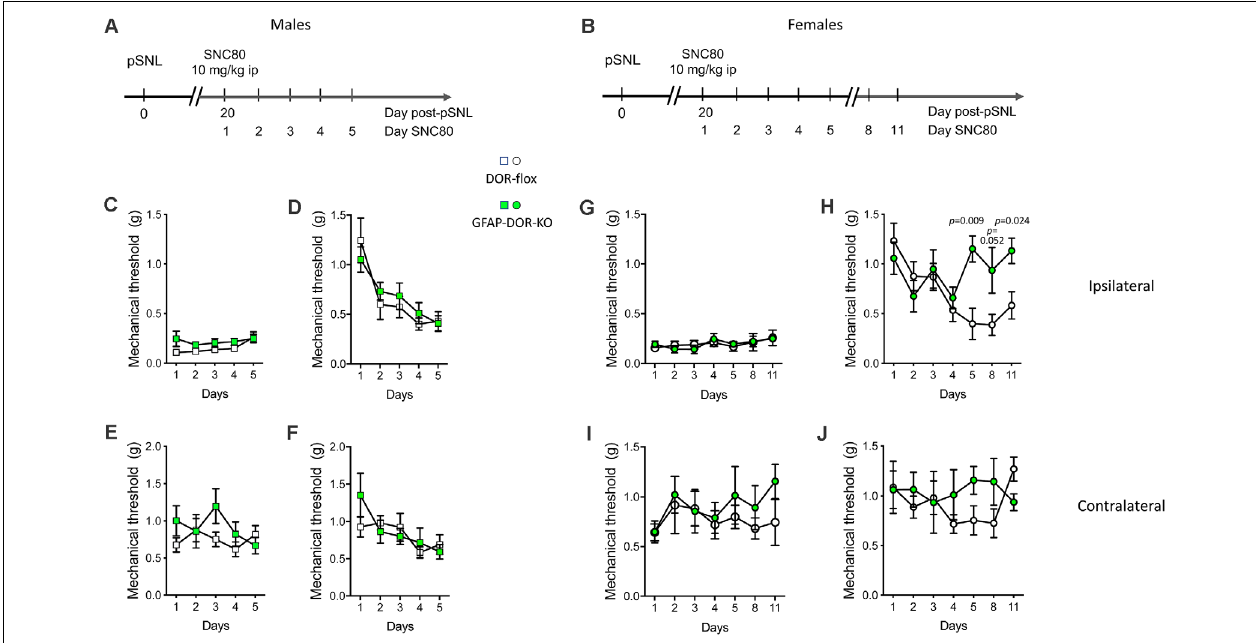
FIGURE 3 | Analgesic tolerance to SNC80 is abolished in GFAP-DOR-KO female mice. (A,B) Experimental design in males and females. SNC80-induced analgesia and analgesic tolerance was scored in neuropathic GFAP-DOR-KO and DOR-flox males (A) and females (B) . (C) Mechanical sensitivity in males each day before SCN80 administration, ipsilateral side. (D) Mechanical sensitivity at ipsilateral side in males following SCN80 administration shows analgesic tolerance in each genotype and no genotype difference. (E) Sensitivity in males each day before SCN80 administration, contralateral side. (F) Sensitivity in males each day after SCN80 administration, contralateral side. n = 13 DOR-flox males, n = 11 GFAP-DOR-KO males, two-way repeated measures ANOVA and one-way repeated measures ANOVA on each genotype followed by Sidak’s multiple comparison tests. (G) Mechanical sensitivity at ipsilateral side in females each day before SCN80 administration. (H) Mechanical sensitivity following SCN80 administration shows that analgesic tolerance occurred in DOR-flox females but did not develop in GFAP-DOR-KO females. (I) Sensitivity in females each day before SCN80 administration, contralateral side. (J) Sensitivity in females each day after SCN80 administration, contralateral side. n = 10 DOR-flox females, n = 7 GFAP-DOR-KO females, mixed effect analysis for genotype comparison followed by Sidak’s multiple comparison test and mixed effect analysis of each genotype followed by Wilcoxon test. P -values for the difference between genotypes are shown when significant ( p < 0.05). Data are expressed as mean ± SEM. See also Supplementary Table 3 for